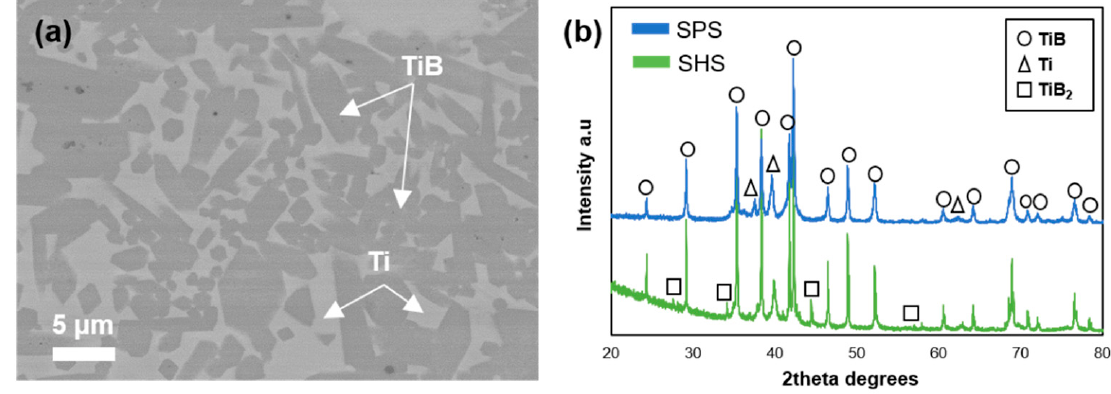
Figure 2. ( a ) SEM image of SPSed (spark plasma sintering) composite; and ( b ) XRD patterns of SHSed powder and SPSed composite.